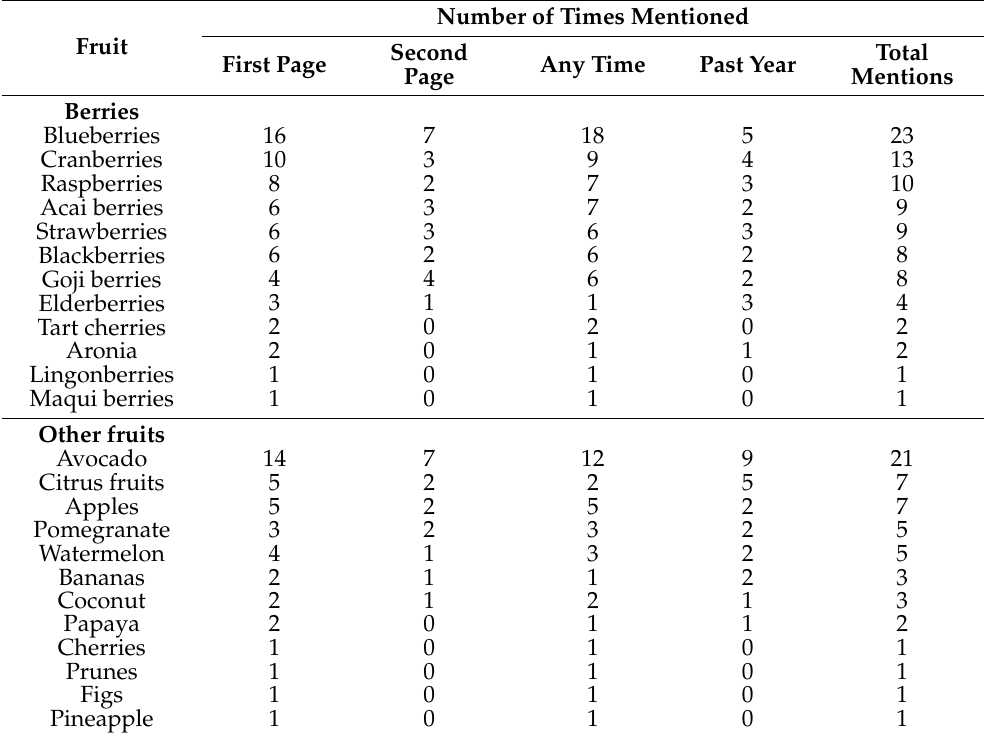
Table 4. Classification of fruits by the number of times that were mentioned on selected web pages.